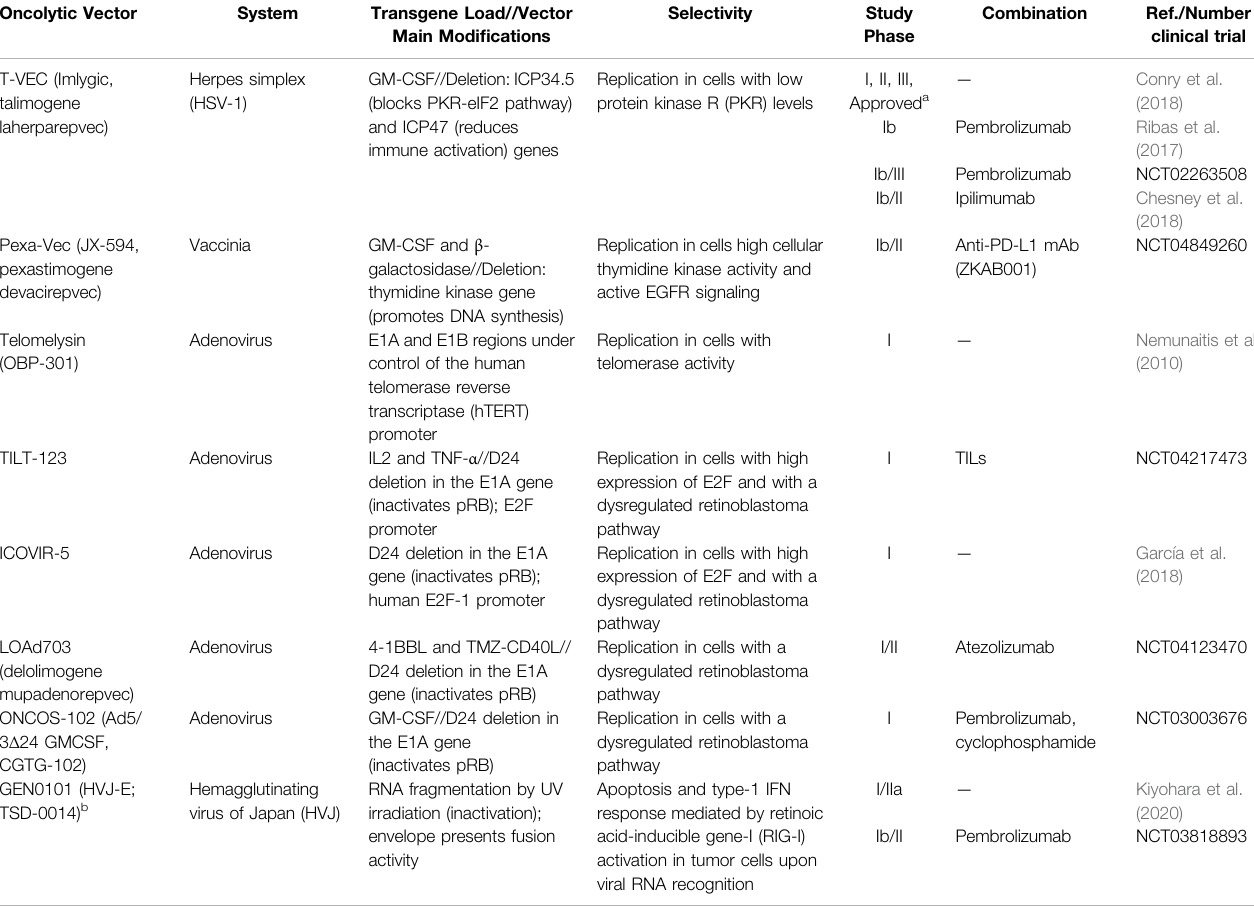
TABLE 1 | Clinical trials for treatment of melanoma with oncolytic viruses. Oncolytic